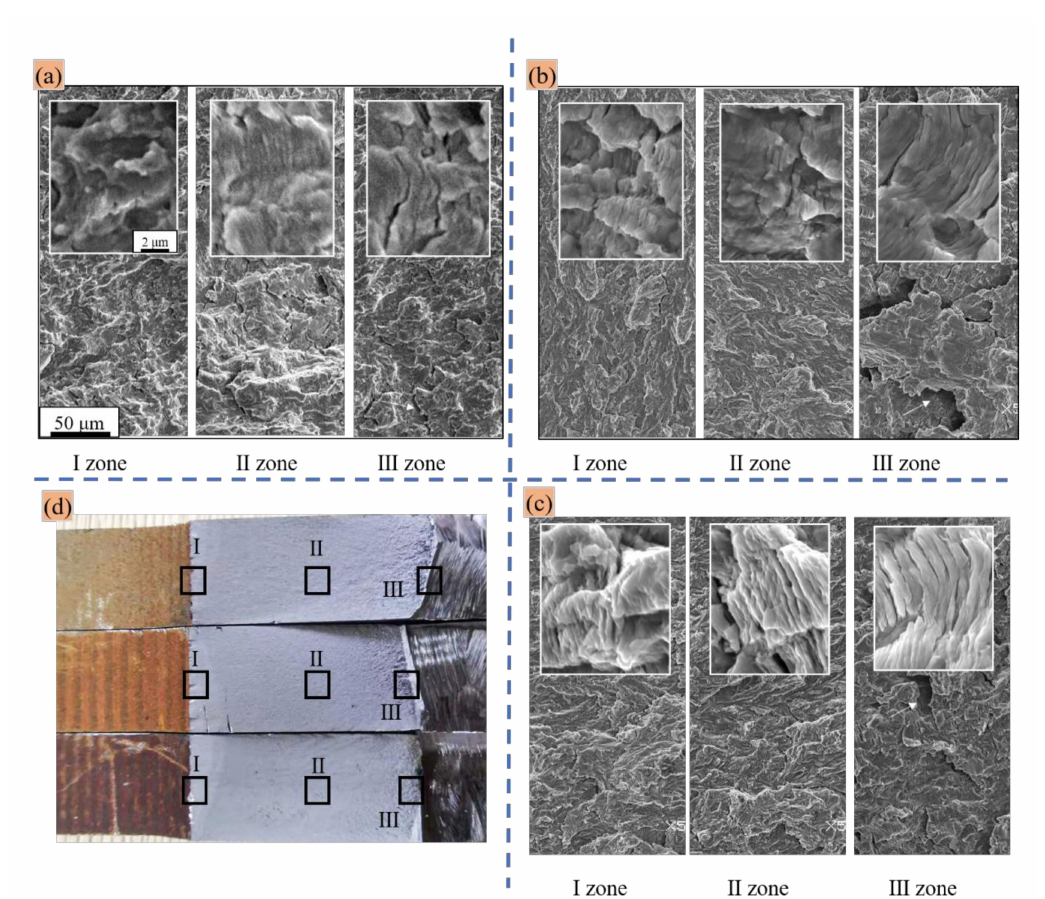
Figure 12. Scanning electron micrographs of the fatigue fracture surfaces: ( a ) EH36T, ( b ) FH36T, ( c ) EH36N and ( d ) image of fatigue